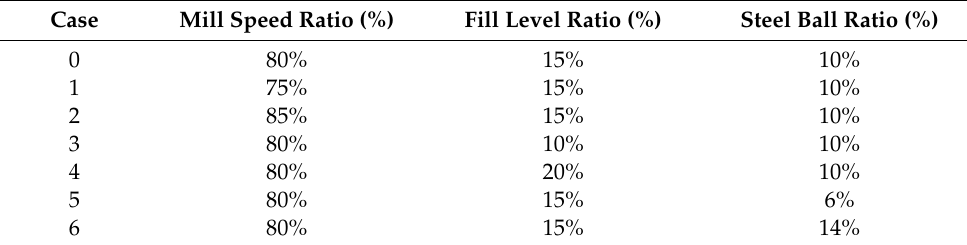
Table 5. Mixed parameter experimental design.